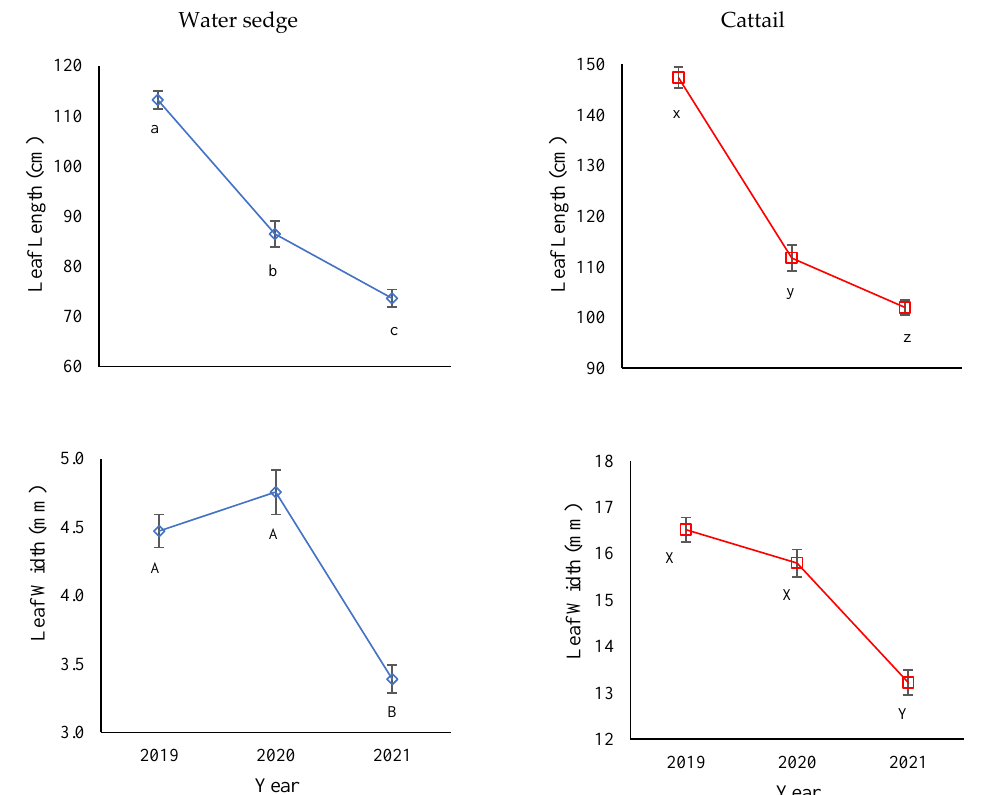
Figure 5. Leaf length (cm) and leaf width (mm) of water sedge and cattail in shallow cells over time (n = 18) in the KTW from 2019–2021. Means within each figure with the same letter are not significantly different (Tukey’s test, α = 0.05).